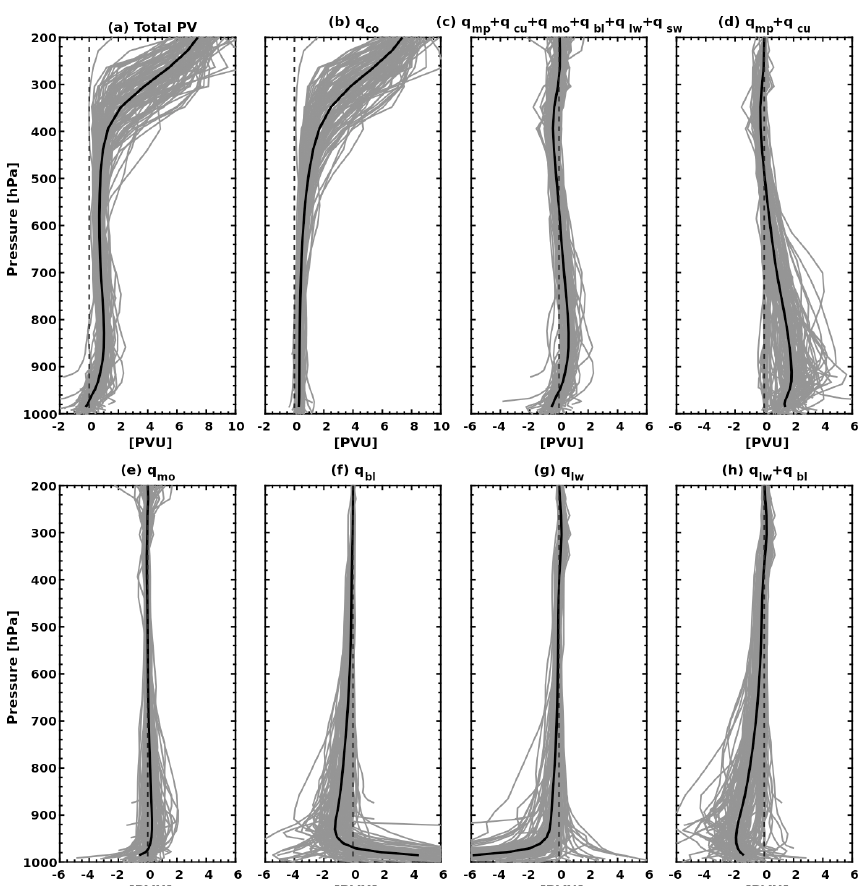
Figure 4. Vertical profiles of total PV and PV tracers for all 100 cyclones (in grey lines), averaged 100km around cyclone centres at the time of their mature stage. Profile averages and 0PVU are shown in solid and dashed black lines, respectively. Note that range of values on the x axis is not common for all